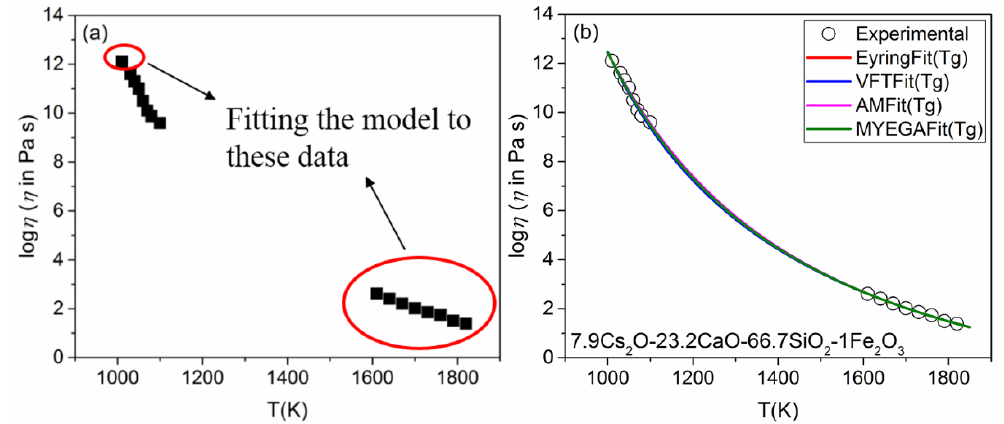
Figure 3. ( a ) Viscosity data of 7.9Cs 2 O-23.2CaO-66.7SiO 2 -1Fe 2 O 3 (the data in the red circle are for fitting); ( b ) results of the low-temperature extrapolation test of the four